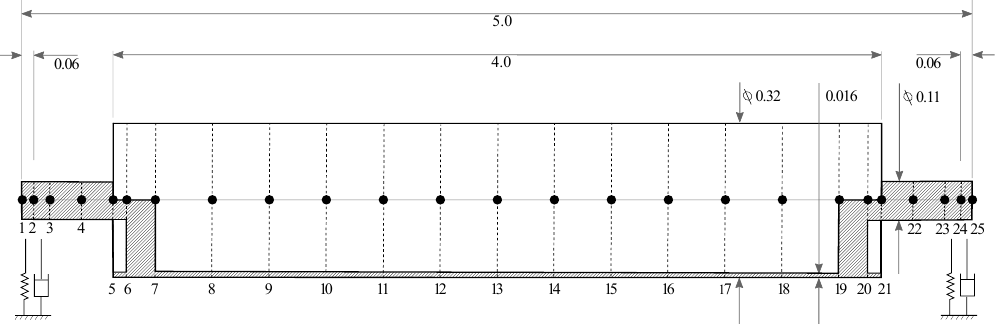
Figure 7. FEM discretized sketch of rotor model. The number below the rotor correspond to the node numbers in the FEM model, whereas the numbers above are the rotor dimensions in